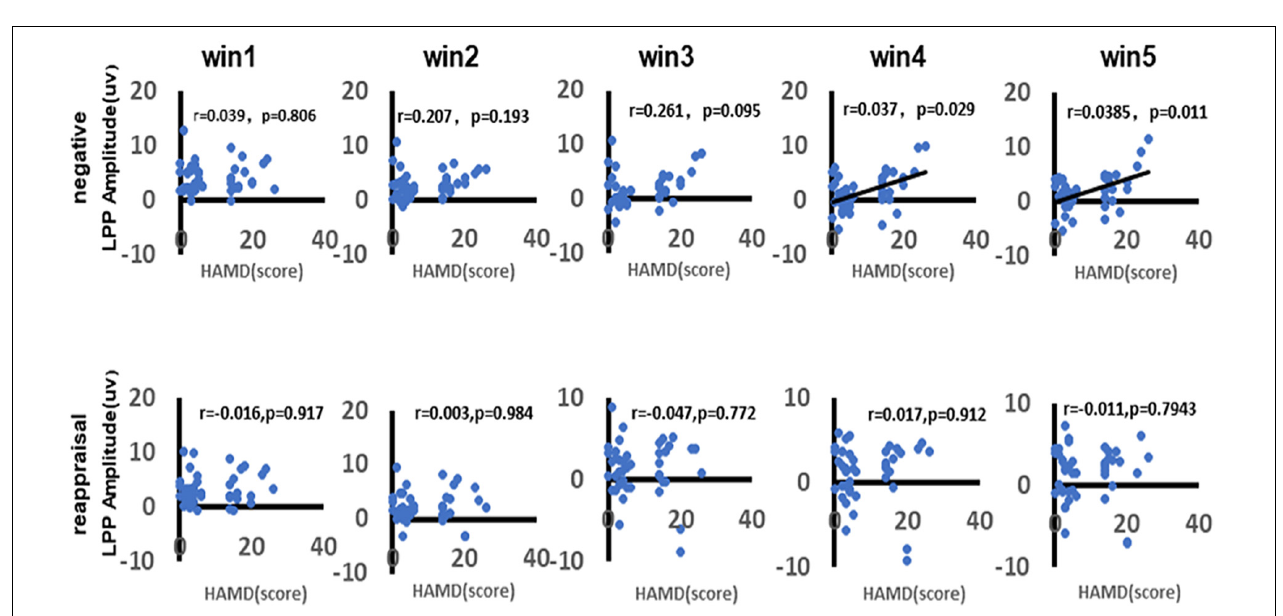
FIGURE 7 | Correlation between depression and emotion regulation. (A) Demonstrates the correlation between depression and valence in response to different stimuli (negative, neutral, reappraisal). (B) Demonstrates the correlation between depression and arousal in response to different stimuli (negative, neutral, and reappraisal).